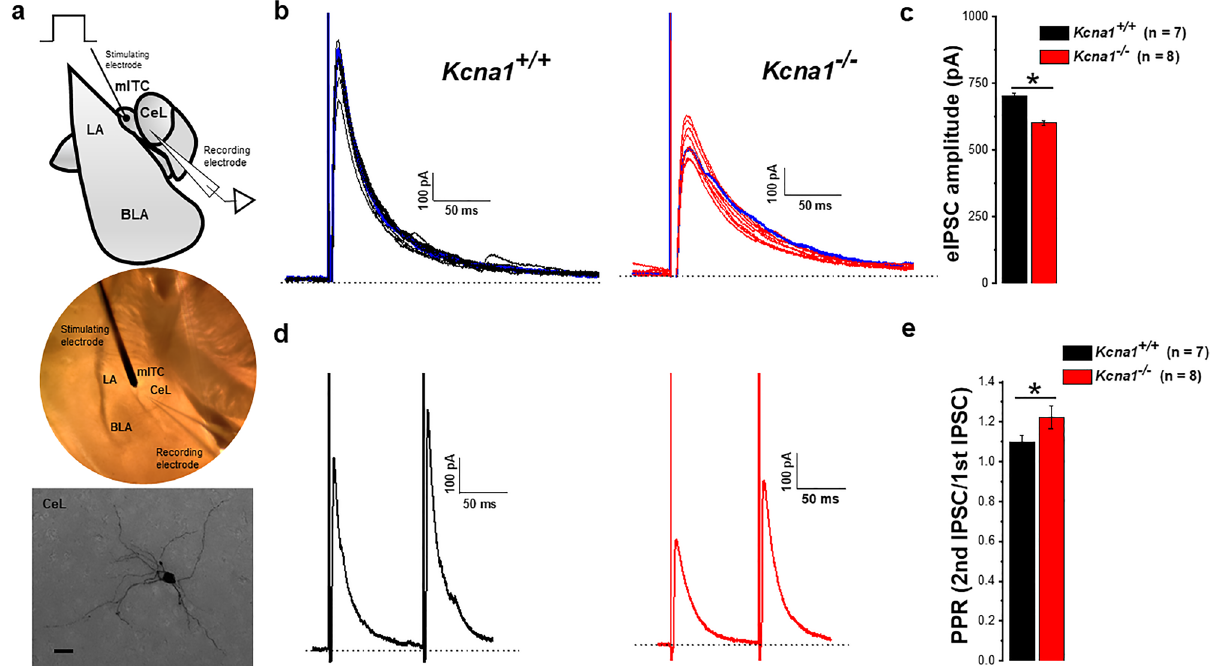
Figure 4. Inhibitory transmission and short-term plasticity at mITC-CeL GABAergic synapses are altered in Kcna1 −/− mice. ( a) Schematic (top) and representative image of experimental preparation ( middle ) of a coronal section of amygdala complex. Note the stimulation electrode placed on the mITCs to evoke inhibitory postsynaptic currents (eIPSCs) in the CeL. Bottom: Image of a representative biocytin-filled recorded CeL neuron showing its typical medium-spiny morphology. Scale bar: 20 µm ( b) Representative current traces (10 consecutive traces overlapped with average trace in blue) of eIPSCs from Kcna1 + / + (black traces) and Kcna1 −/− (red traces) mice recorded from a holding potential of 0 mV. ( c ) Mean values of eIPSCs amplitude calculated from the average responses obtained for each cell at a frequency of 0.1 Hz. The data show that the amplitude of eIPSCs at mITC-CeL synapses is significantly decreased in Kcna1 −/− compared to Kcna1 + / + mice, suggesting that basal synaptic strength is impaired at mITC-CeL synapse of Kcna1 −/− . Kcna1 + / + , n = 7 cells from 4 mice; Kcna1 −/− , n = 8 cells from 6 mice. (d ) Representative averaged trace obtained with a paired-pulse protocol (10 successive responses at 10 Hz) showing eIPSCs short-term facilitation in CeL neurons from Kcna1 + / + (black trace) and Kcna1 −/− (red trace) mice. A train of 10 pulses at 10 Hz was used ( e ) Mean values of pair-pulse ratio (PPR) evoked by pair stimuli (100 ms interstimulus interval) in mITC-CeL synapses. The PPR is increased in Kcna1 −/− compared to Kcna1 + / + mice. These data suggest that the release probability from presynaptic GABAergic terminal at mITC-CeL synapse is decreased in Kcna1 −/− mice. Kcna1 + / + , n = 7 cells from 4 mice; Kcna1 −/− , n = 8 cells from 6 mice. Dotted lines indicate the base line . LA, Lateral amygdala; BLA, Basolateral amygdala; CeL, Central lateral amygdala; and mITC, medial intercalated cells. The schematic ( a , top panel) was made using curved line tool in PowerPoint and the image of biocytin filled recorded CeL neuron ( a , bottom panel) was processed using the ImageJ-Fiji version 1.53j. *p <